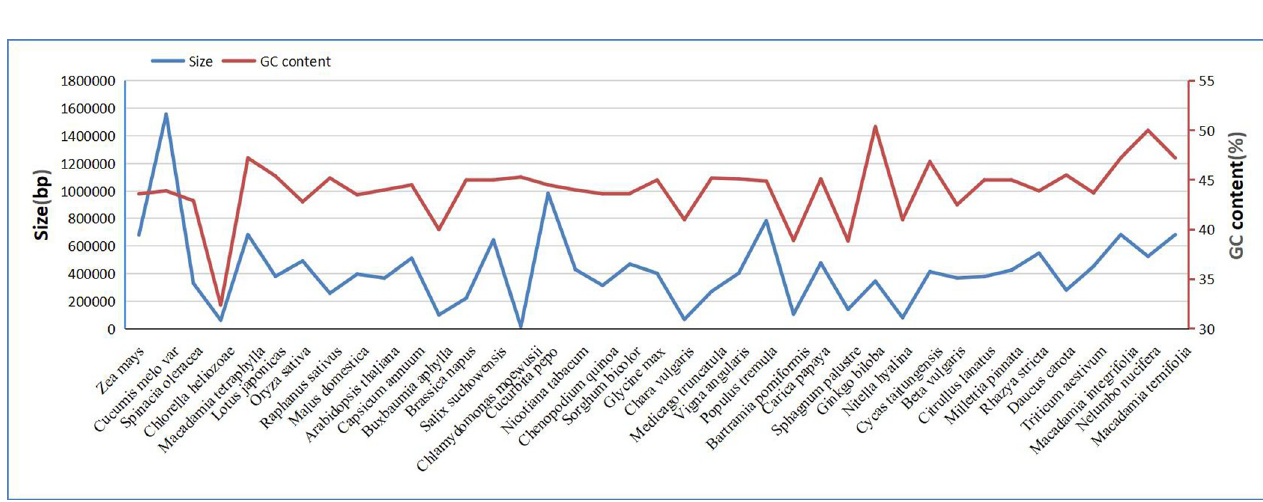
Fig 2. The sizes and GC contents of 39 plant mitochondrial genomes. The blue dots represent the genome size and the orange trend line shows the variation of GC content across the different